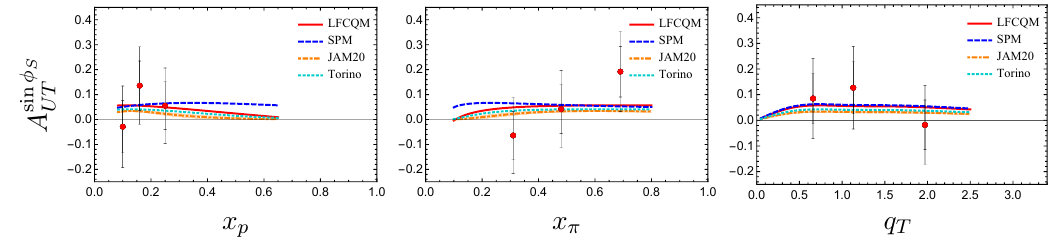
Figure 5 . A sin (cid:30) as a function of x p (left), x (cid:25) (middle) and q T (right) vs COMPASS data [46]. UT